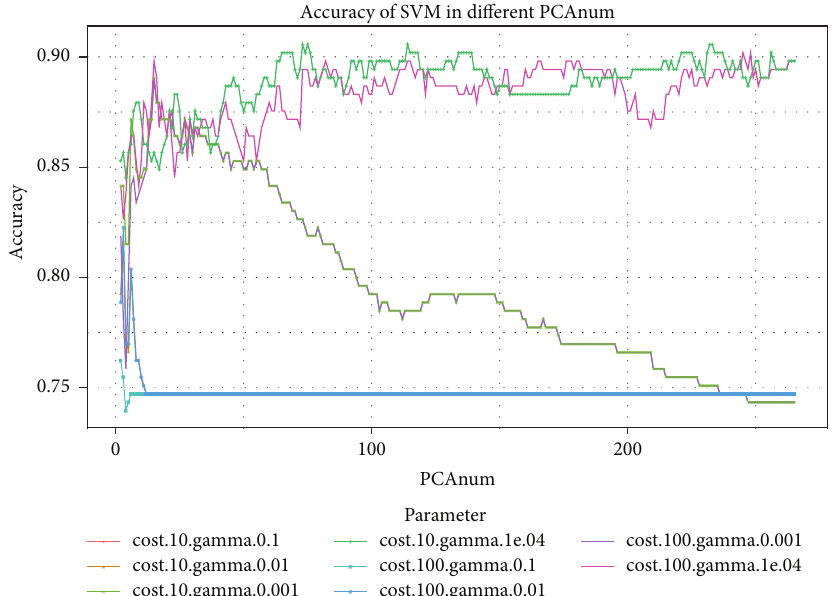
Figure 9: Comparison of correct rate of SVM optimization parameters.